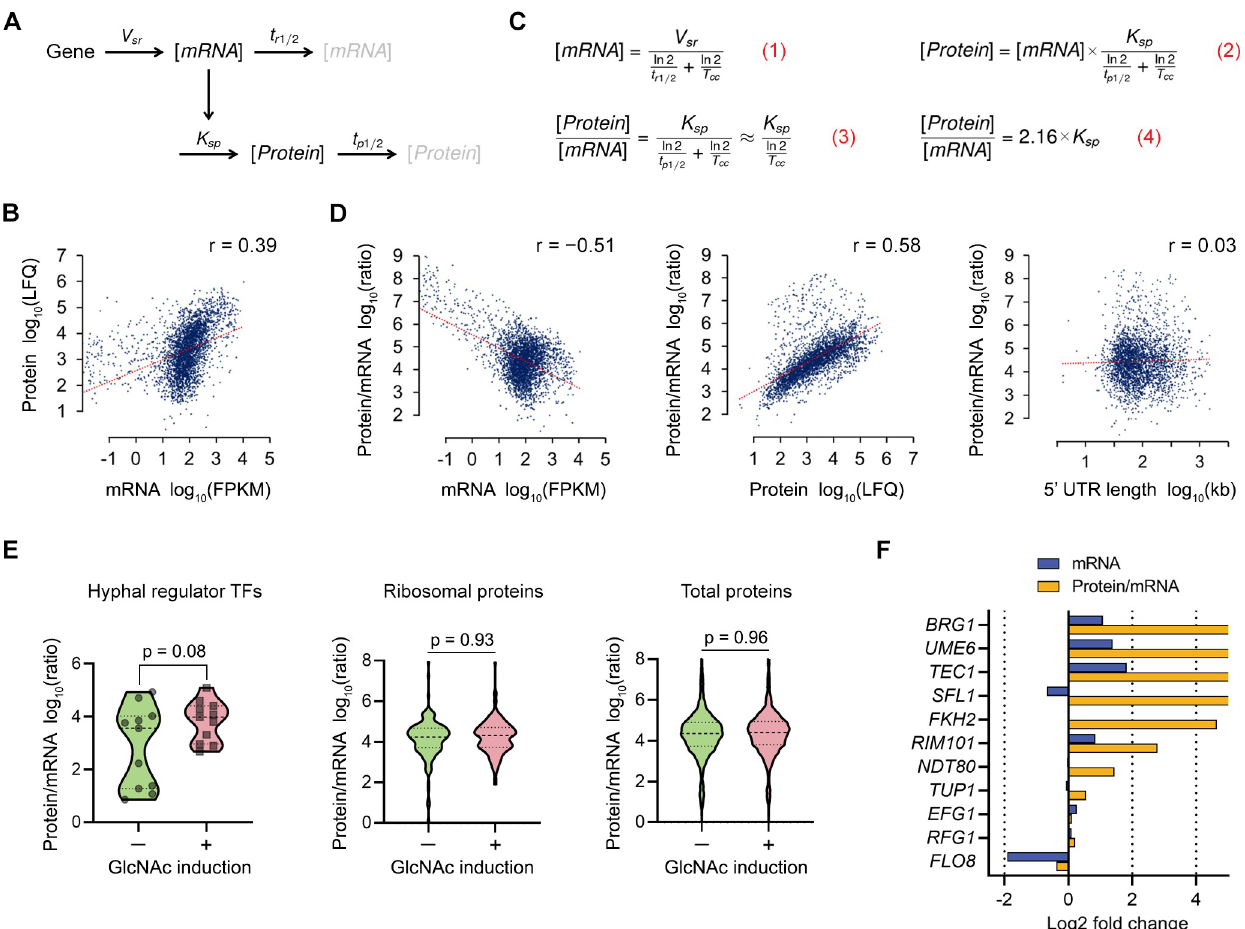
Fig 5. Integrated transcriptomic and proteomic analyses indicate that hyphal stimulation induces translation of hyphal regulator TFs. (A) A basic gene expression model with key parameters (adapted from REF. [56,92]). The mRNA is transcribed with rate V and degraded with a half-life represented sr by t r1/2 . The protein is translated proportionally to the mRNA abundance with the rate constant K sp and degraded with a half-life of t p1 / 2 . (B) An across-gene correlation analysis comparing estimates of absolute mRNA abundance (expressed in fragments per kilobase of transcript per million mapped reads (FPKM)) to protein abundance (expressed as label free quantitation (LFQ)) in exponentially growing WT cells. r, Pearson correlation coefficient. (C) Mathematical expression of mRNA (Eq 1) and protein abundances (Eq 2) as a function of key gene expression parameters, including cell doubling time T , cc as detailed in REF. [92]. Rearranging Eq 2 yields the dependency of protein-mRNA abundance ratio on the translation rate constant K , cell doubling time sp T cc , and protein half-life t p1/2 (Eq 3). We neglected protein degradation assuming that protein replacement is generally driven by dilution due to cell division in exponentially growing C . albicans cells ( t >> T ). Substituting the cell doubling time ( T = 1.5 h in C . albicans ) yields Eq 4. Therefore, we can p1/2 cc cc approximate the translation rate with the protein-to-mRNA level ratio. (D) Across-gene correlation analyses comparing protein-to-mRNA ratio versus mRNA abundance, protein abundance, and 5’ UTR length (from left to right). r, Pearson correlation coefficient. (E) Protein-to-mRNA ratios of 11 selected hyphal regulator transcription factors (TFs) during GlcNAc induction in WT. The protein-to-mRNA ratios of the 5 hyphal regulators were two orders of magnitude lower than the median in − GlcNAc control, indicating their translation rate was very low before hyphal induction. The p-value was calculated using two-sided unpaired t-test (hyphal regulator TFs) and z-test (ribosomal proteins and total proteins). (F) The relative change in protein-to-mRNA ratio for the selected 11 hyphal regulators is shown in yellow, relative changes in mRNA expression are shown in blue. The protein-to-mRNA ratio of UME6 , SFL1 , BRG1 , TEC1 , and FKH2 increased dramatically (log2 fold change > 4) during hyphal induction while mRNA levels did not. Since protein levels are a function of mRNA abundance, translation rate, and protein turnover, we approximated the translation rate with the protein/mRNA level ratio (this approximation neglects protein degradation, see Fig 5C). Integration of RNA-seq and label-free LC-MS/MS data gave an opportunity to estimate the translation rate of 3,267 genes (S4 Data). The transla- tion rate spanned over five orders of magnitude across genes (Fig 5D). There was a negative correlation between mRNA abundance and translation rate, while there was a positive